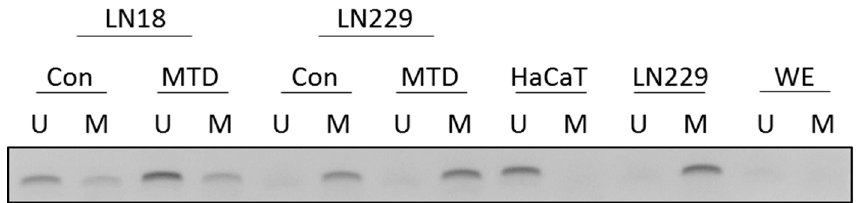
Figure 11. MGMT promoter methylation in glioma cells cultivated in the absence and presence of methadone. Con, control without MTD; MTD, 10 µg/mL for a period of 72 h. Separately harvested extracts of non-treated human HaCaT cells were used as a control for the unmethylated promoter, and LN229 for the methylated promoter. WE, without cell extract. U, unmethylated; M, methylated.